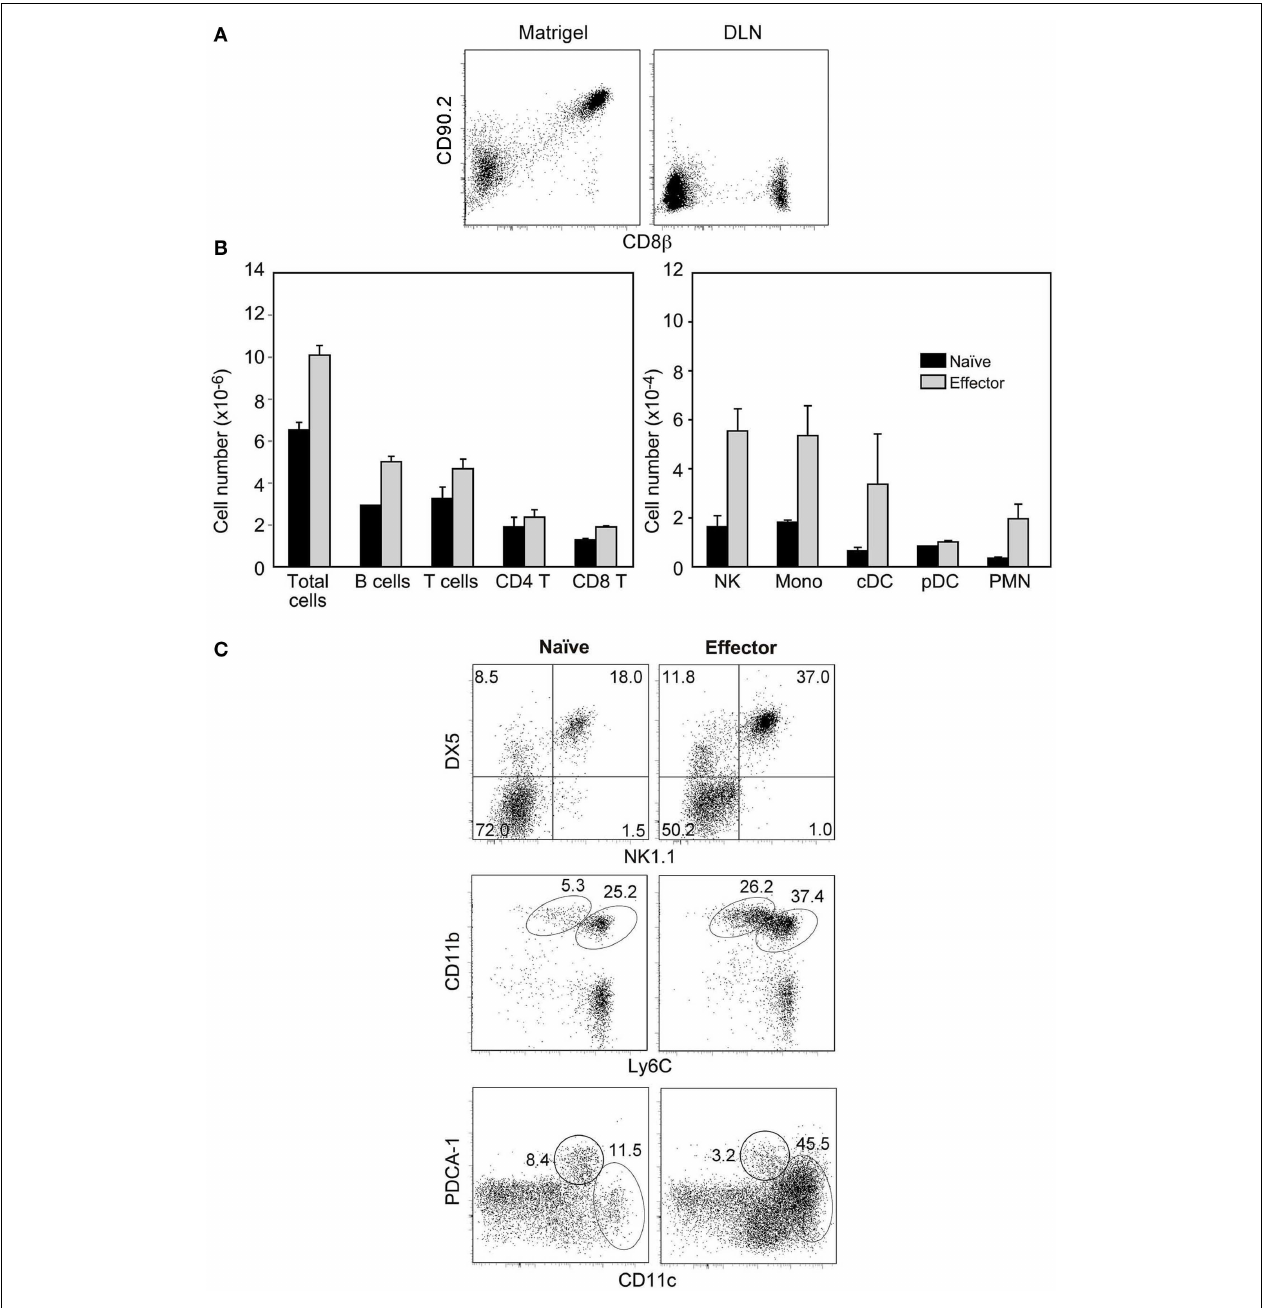
injection. (B,C) Cell populations recovered in the ALN of injected mice, 24h after injection. (B) Results show cell numbers and are mean ± SEM of three independent experiments. (C) Results show the gates used to identify different cell types and are from one representative experiment out of the three we